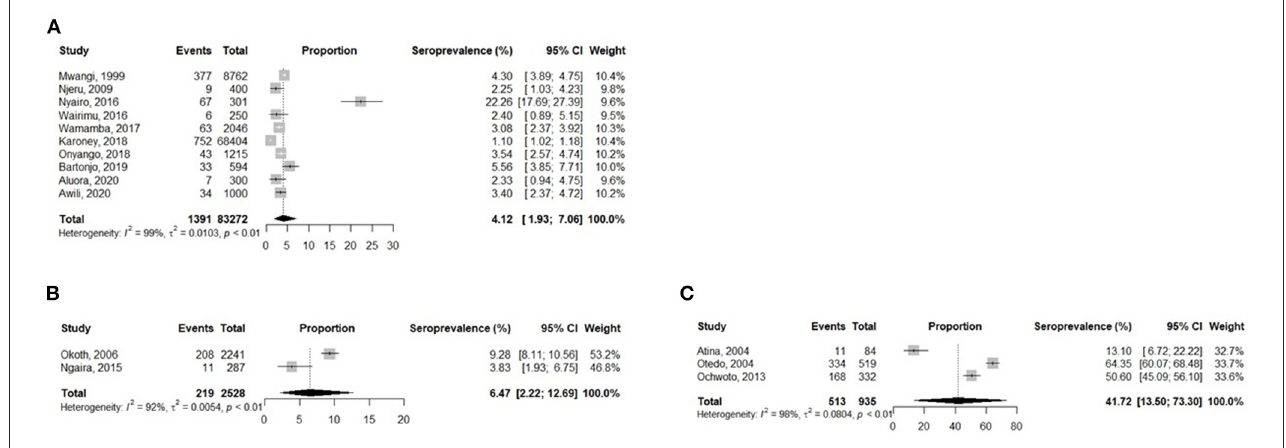
FIGURE3 Analysis of the prevalence of HBV in Kenyan Blood Donors (A) , Pregnant women (B) , and Jaundice patients (C) .